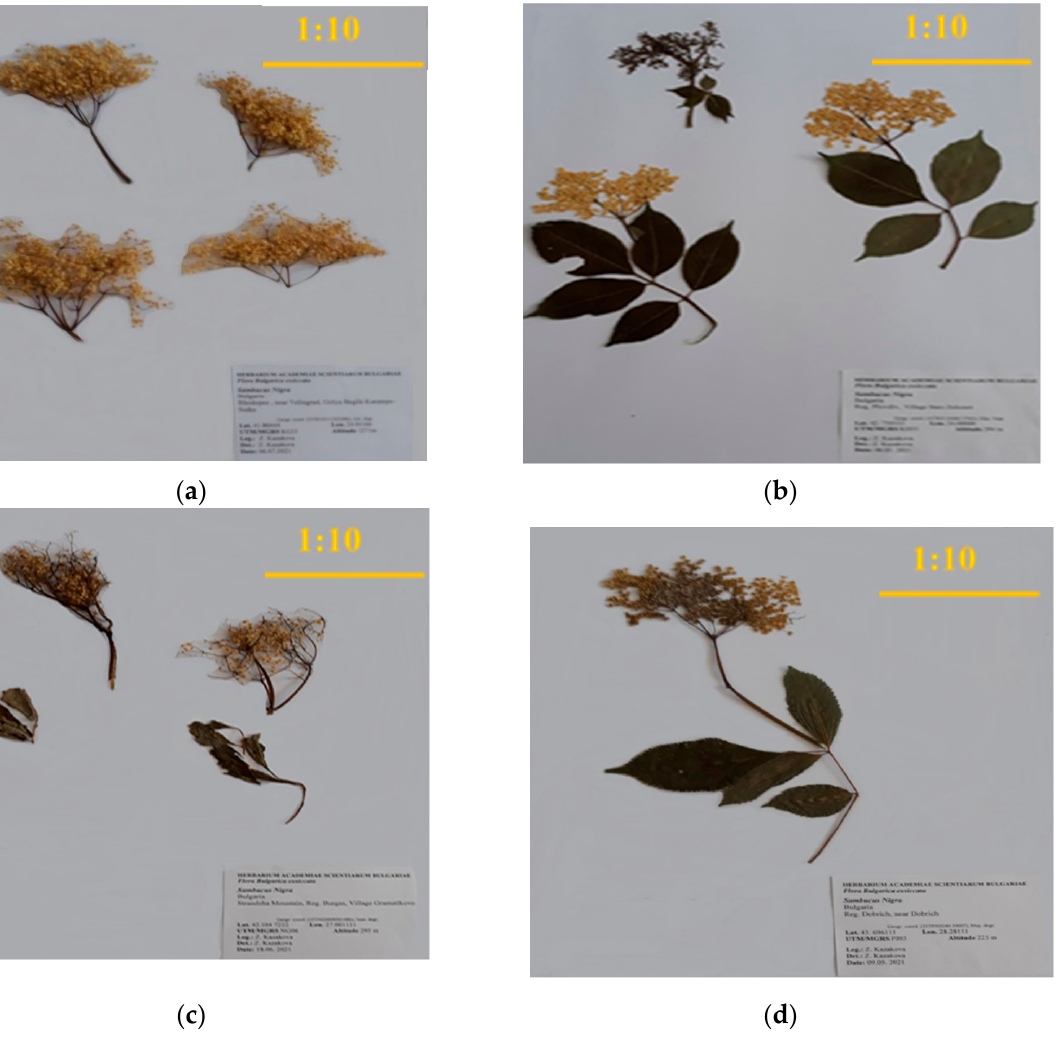
Figure 1. Sambucus nigra L . from different regions of Bulgaria. ( a ) Western Rhodopes, Velin-grad, Golyam Beglik–Karatepe–Sutka; ( b ) Staro Zhelezare village, Plovdiv region; ( c ) Gramatikovo vil- lage, Strandzha; ( d ) Dobrich region.